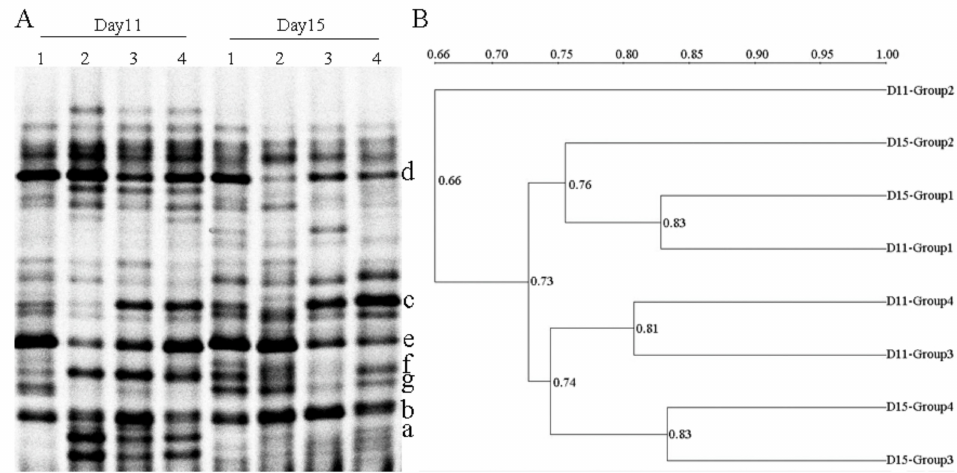
Figure 4. Representative denaturing gradient gel electrophoresis (DGGE) profiles ( A ) and unweighted pair group method using arithmetic average (UPGMA) dendrograms ( B ) of intestinal microflora at di ff erent time intervals. D11: the 11th day of the experiment. D11-Group 1: mice treated with normal water; D11-Group 2: mice treated with 3% DSS alone; D11-Group 3: mice treated with DSS plus chitosan (250 mg / kg); D11-Group 4: mice treated with DSS plus chitosan (150 mg / kg). D15: the